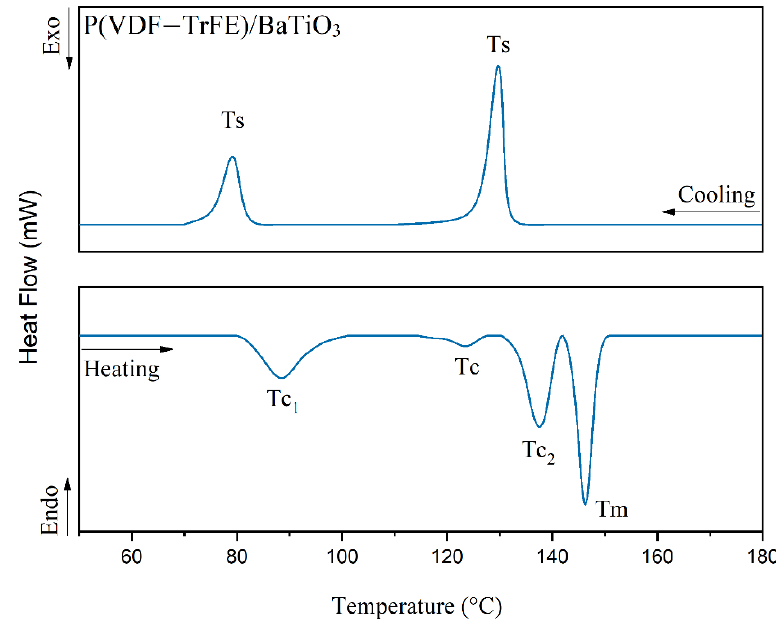
Figure 5. DSC thermogram of P(VDF-TrFE)/BaTiO 3 film at 50 °C to 180 °C.